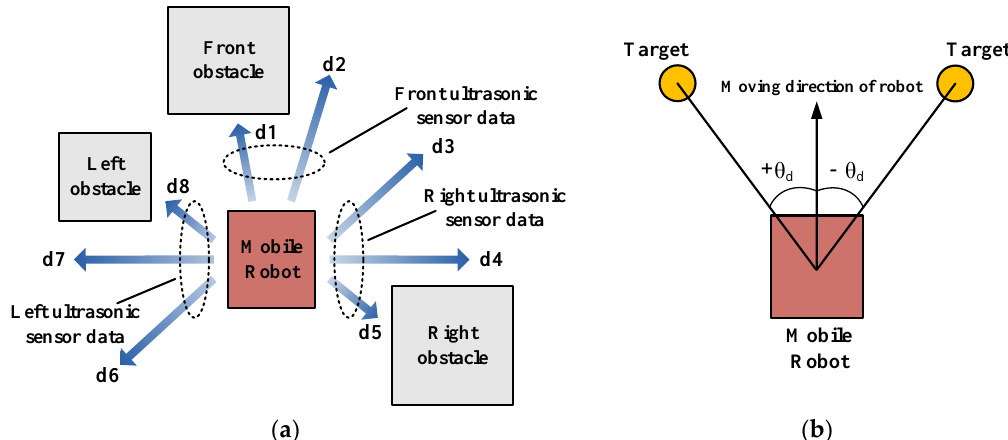
Figure 5. Performance of sensor systems of mobile robot: ( a ) description of distance sensors; ( b ) description of positioning system.